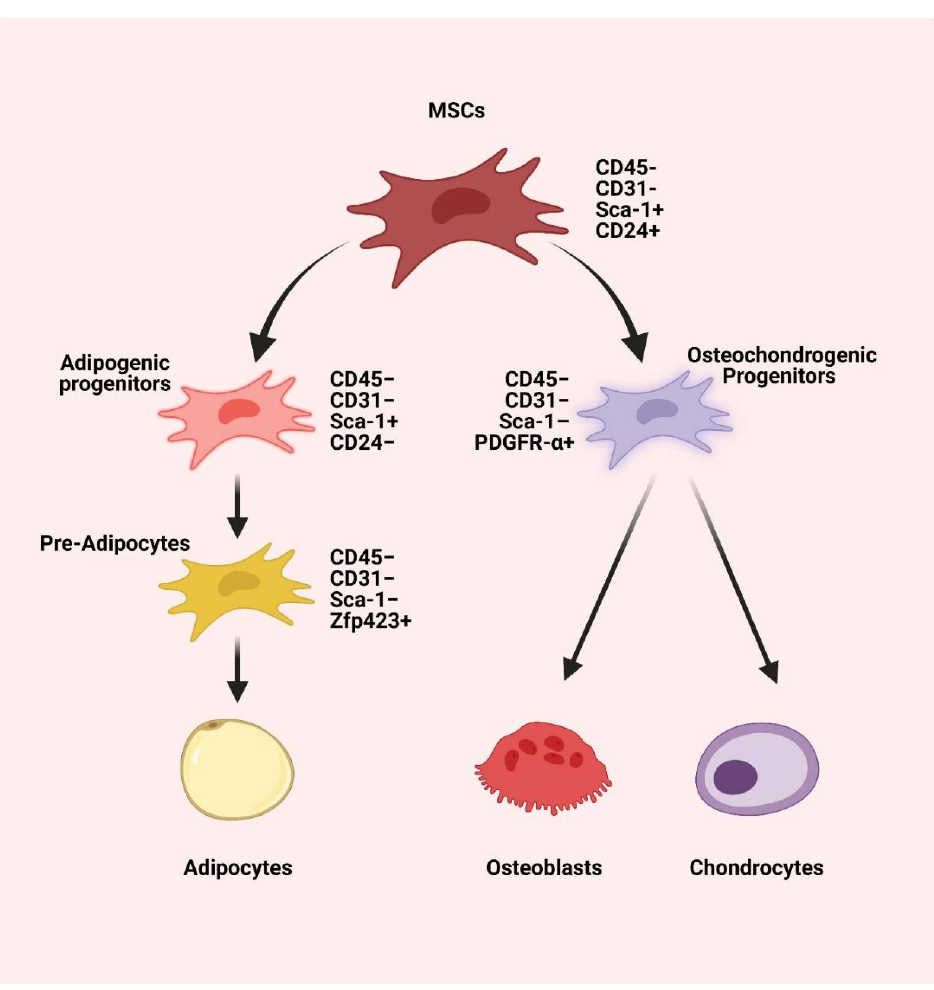
Figure 1. The trilineage differentiation potential of MSCs is characterized by CD45− CD31− Sca-1+ CD24+. The MSCs give rise to osteochondrogenic progenitors that are characterized by CD45− CD31− Sca-1– PDGFR-α+ and adipogenic progenitors characterized by CD45− CD31− Sca-1+ CD24−. The osteochondrogenic progenitors differentiate into chondrocytes and osteoblasts, while adipo- genic progenitors differentiate into CD45− CD31− Sca-1− Zfp423+ pre-adipocytes, which leads to adipocytes differentiation [25]. Created with BioRender.com (accessed on 20 December 2021).